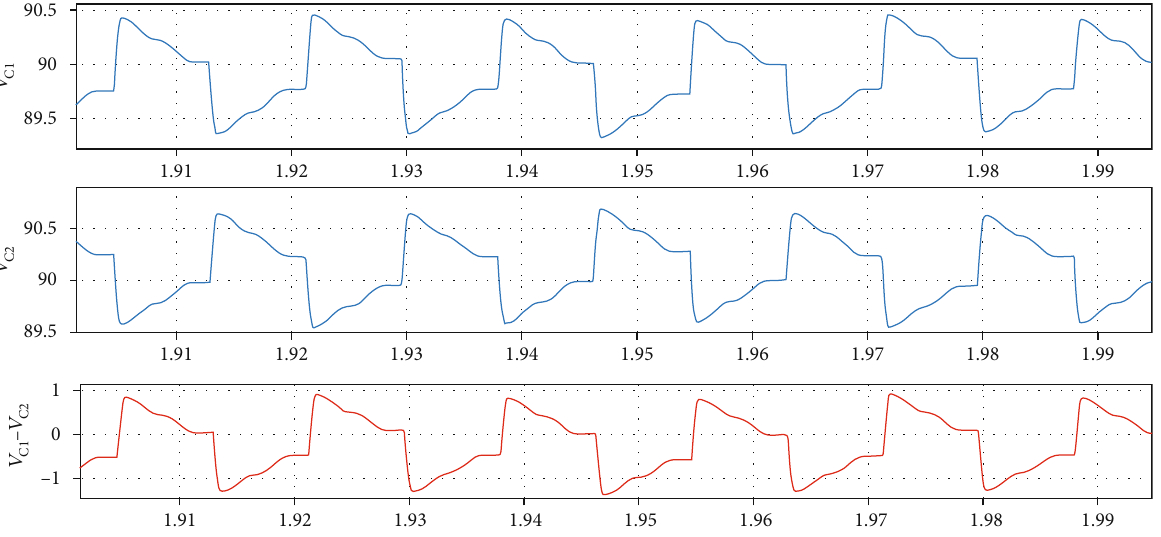
= 180 , VAC = 110 , and THD v = 2 : 6 % . DC